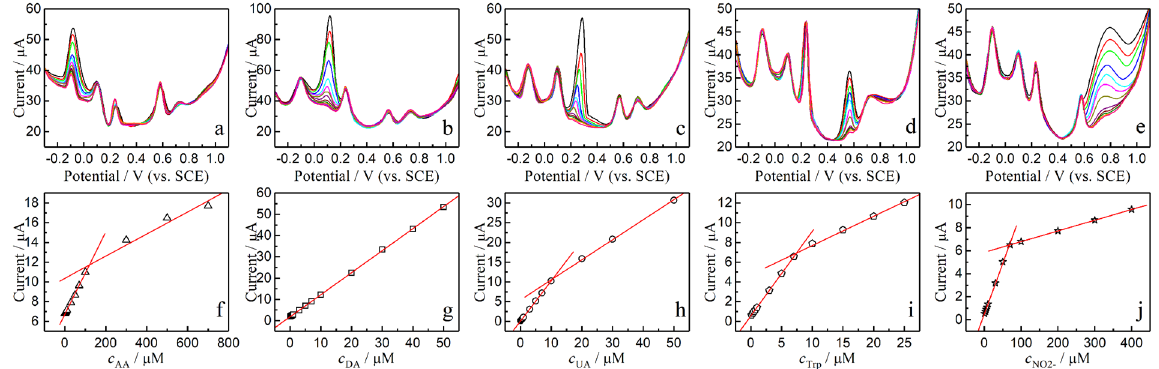
Figure 4. ( a – e ) DPVs of the graphene/Ta wire electrode for selective determination of AA, DA, UA, Trp, and − NO